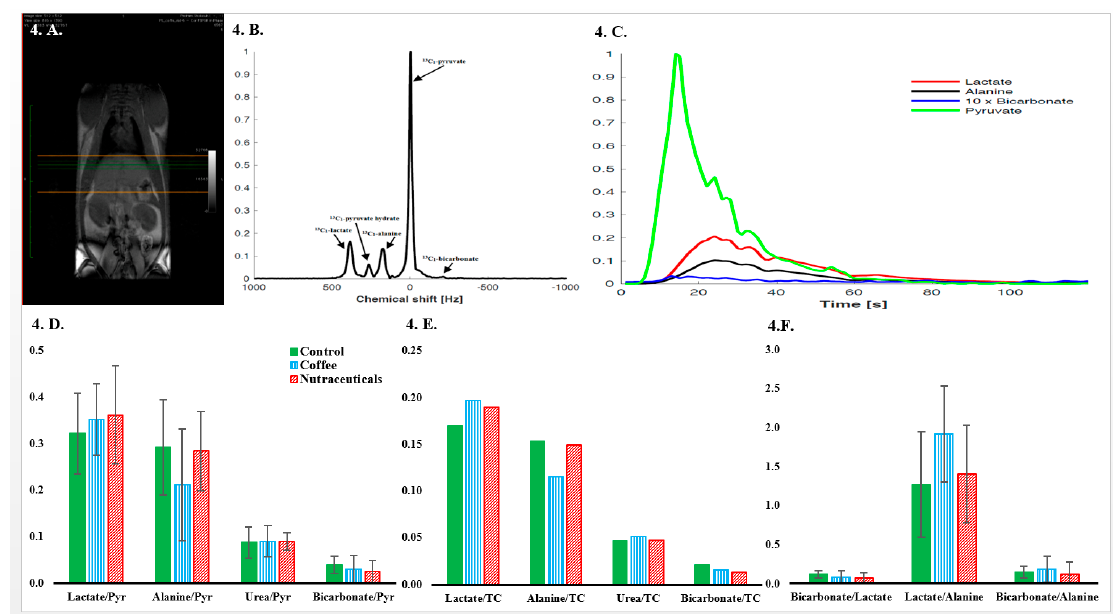
Figure 4. ( A ) A typical full-torso coronal 1 H MR image; ( B ) a representative 2D 13 C sum spectra observed after injecting the hyperpolarized [1- 13 C]-pyruvate; ( C ) changes in the signal intensity of metabolites over the 60-s scanning period; ( D ) area under the curve of signal intensity ‒ time curves of each metabolite normalized to [1- 13 C]-pyruvate and ( E ) total carbon. ( F ) Signal intensity ratios between pyruvate metabolites; error bars represent the standard deviation of the mean.